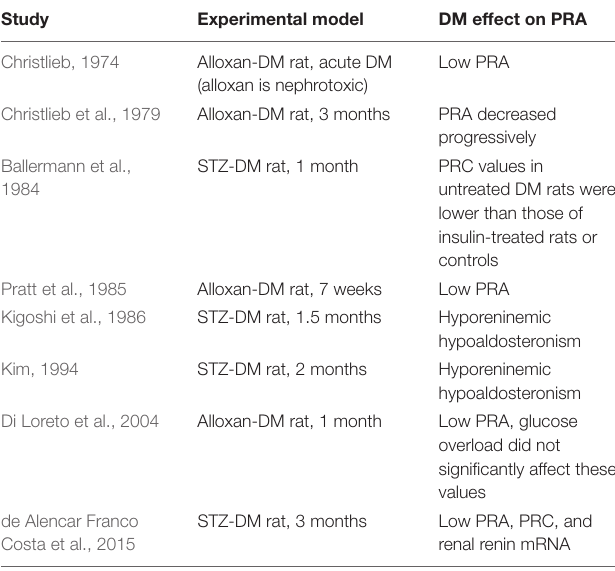
TABLE 3A | Preclinical studies that determined PRA in experimental